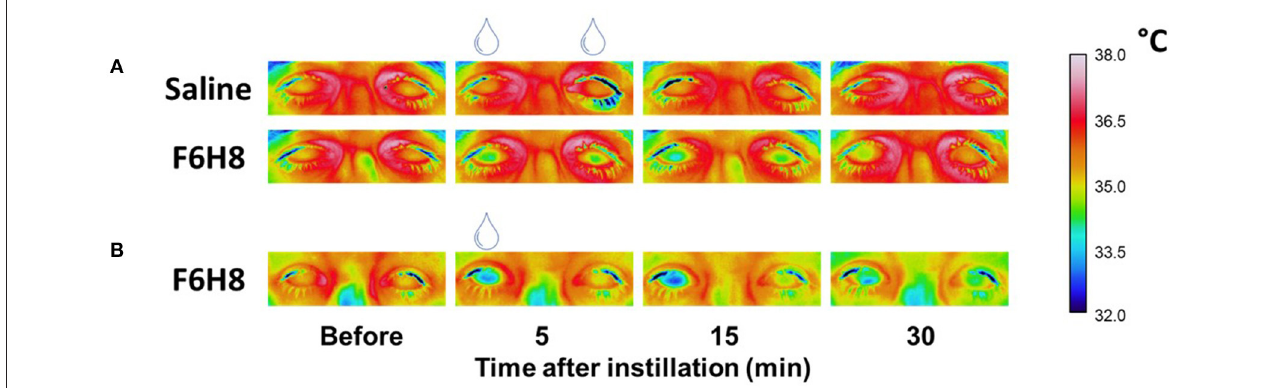
FIGURE 1 | Representative examples of the infrared video images of both eyes taken to define the CST changes after bilateral topical application of saline or F6H8 (A) or unilateral (right eye) topical application of F6H8 (B) .